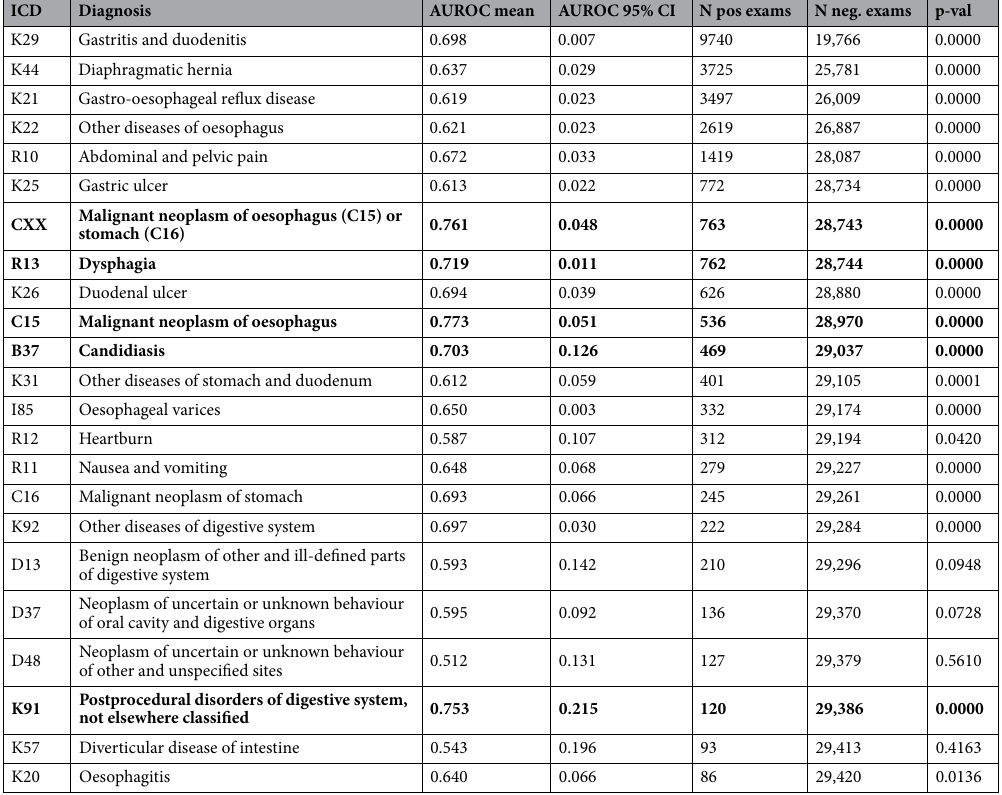
Table 1. Target diseases and classifier performance for the gastroscopy dataset. All targets which reached an area under the receiver operating curve (AUC, mean ± standard deviation [std]) of above 0.70 are highlighted in bold. N pos./neg. exams = number of positive/negative examinations (with and without diagnosis, respectively). P-val. P-value for examination scores between